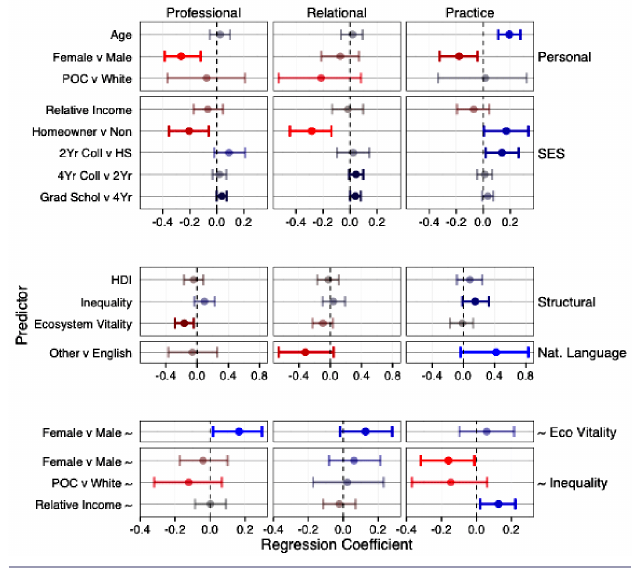
Fig. 4 . Model results show effects of socio-demographic and structural factors on dimensions of participation. The position of points for each predictor across three x-axes shows the mean of the posterior distribution, analogous in practice to estimated coefficients in a frequentist framework. The zero line indicates no effect of the predictor. Error bars represent 95% Highest Posterior Density, and are analogous in practice to 95% confidence intervals in a frequentist framework. Points and error bars are colored to show effect size, as the absolute value of the coefficient. Predictors not significant at 90% credibility are shown at 50% transparency. SES indicates socioeconomic